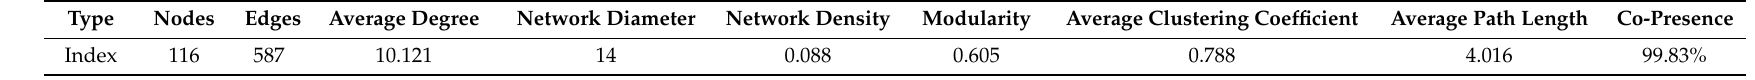
Table 2. Network indices obtained through network analysis from fungal communities of the four native grasses.